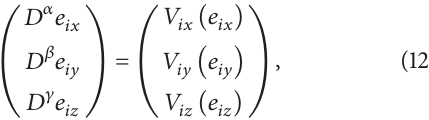
𝑘 (1 − 𝑆 )𝑆 𝑢 𝑗𝑧 𝑗 𝑗 𝑗𝑧 vanish because